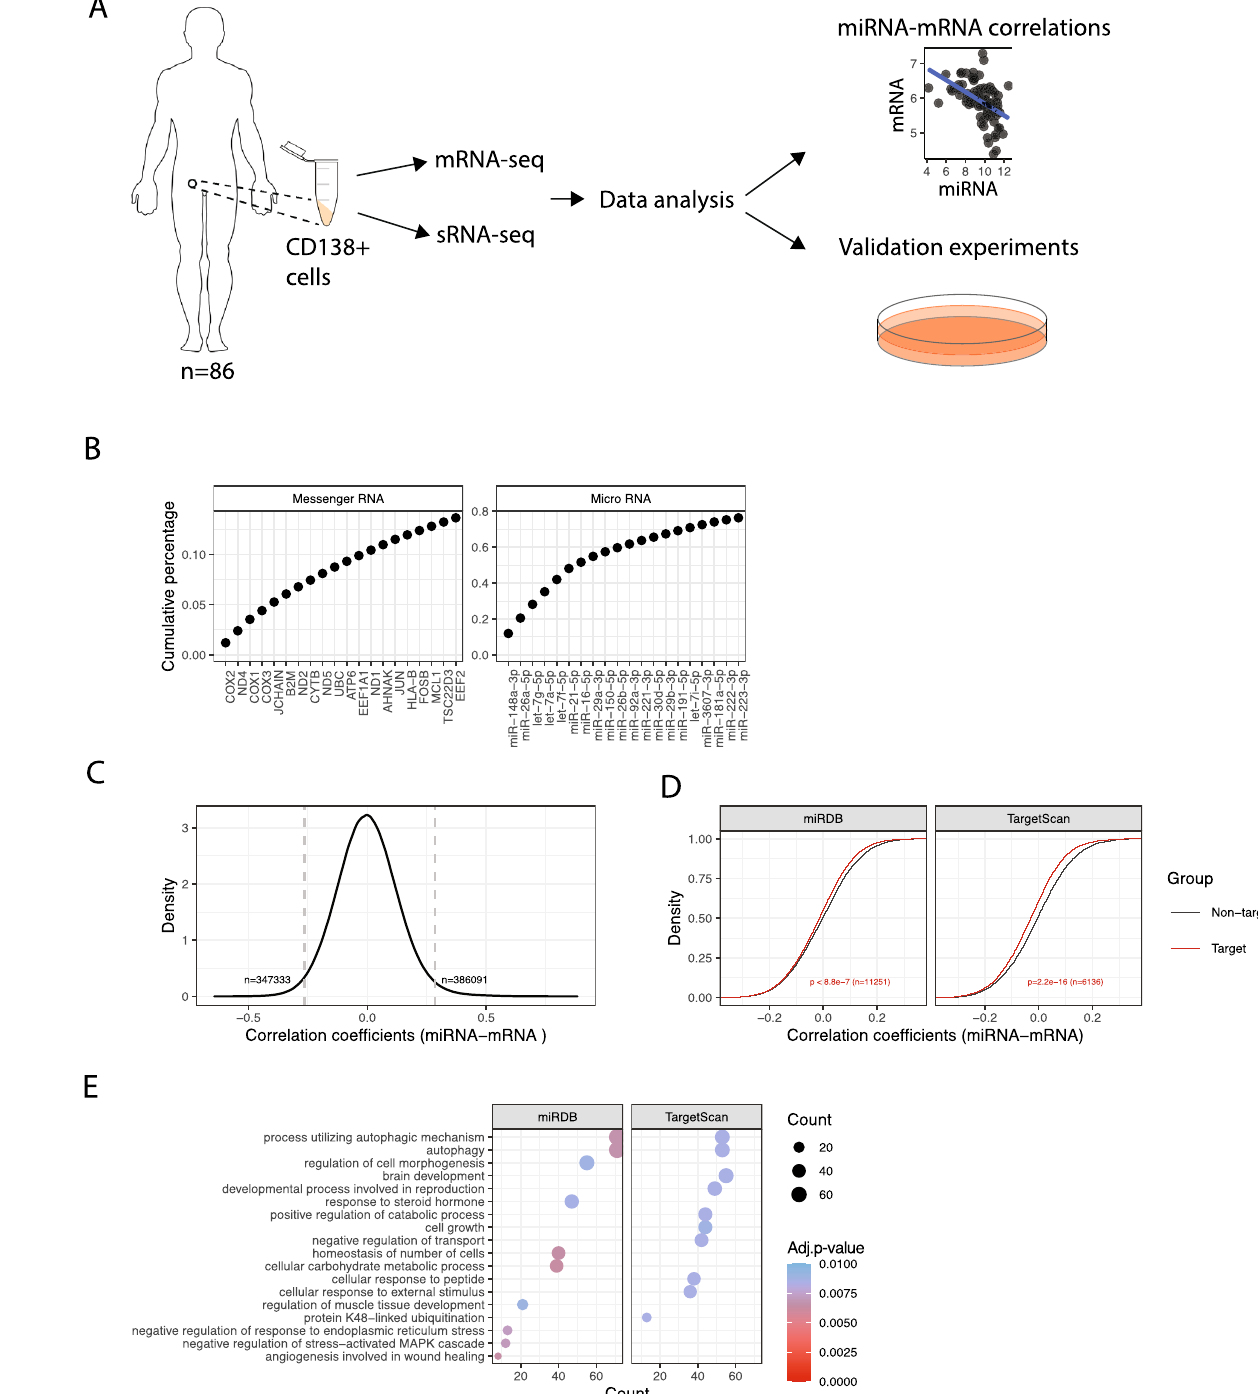
Figure 1. ( A ) Study design and analysis overview ( B ) Cumulative expression of the top 20 highest expressed mRNAs (left) and miRNAs (right). ( C ) Density plot showing the distribution of correlation coefficients for all miRNA-mRNA Pearson’s correlations. Indicated is the number of significant positive correlations (n = 386,091) and significant negative correlations (n = 347,333). ( D ) Cumulative distribution of miRNA-mRNA correlation coefficients for in silico predicted miRNA targets and non-targets. Shown are targets predicted by miRDB and TargetScan. The p-values represent the difference between the target and non-target groups and the numbers indicate the number of predicted miRNA-target pairs. ( E ) Gene ontology analysis of the genes with most significant miRNA-mRNA correlations and the best in silio prediction score for miRDB and TargetScan and (n = 1327 and 874 for miRDB and TargetScan targets, respectively) (see Methods). The color of the dots and the color legend “Adj. p -value” indicate the Benjamini–hochberg adjusted p -value. The size of the dots and the legend “Count” indicate the gene ratio (see Methods). Shown is the gene ontology for biological